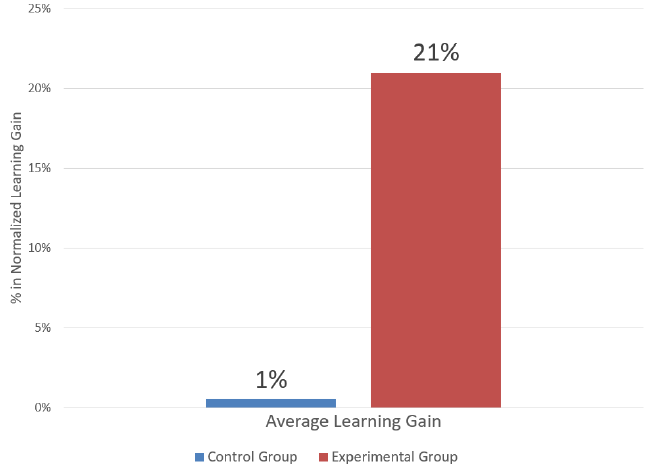
Figure 6. Control and experimental group’s average Normalized Learning Gain (NLG).